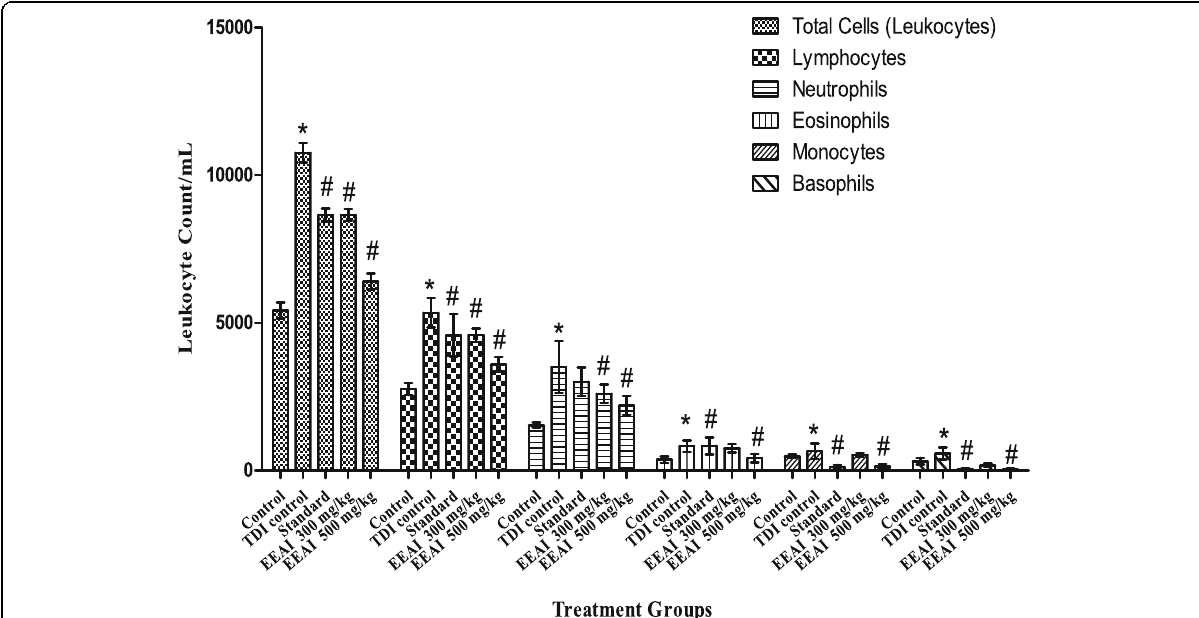
Fig. 3 Suppressive effect of A. ilicifolius extract on total blood cells (leukocytes) count and differential blood cells count in mice.Values are expressed as